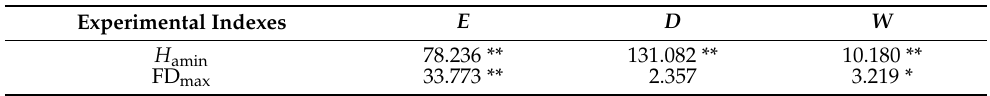
Table 4. Variance analysis of the influence of experimental factors on minimum closing pressure ( H amin ) and maximum flushing duration (FD max